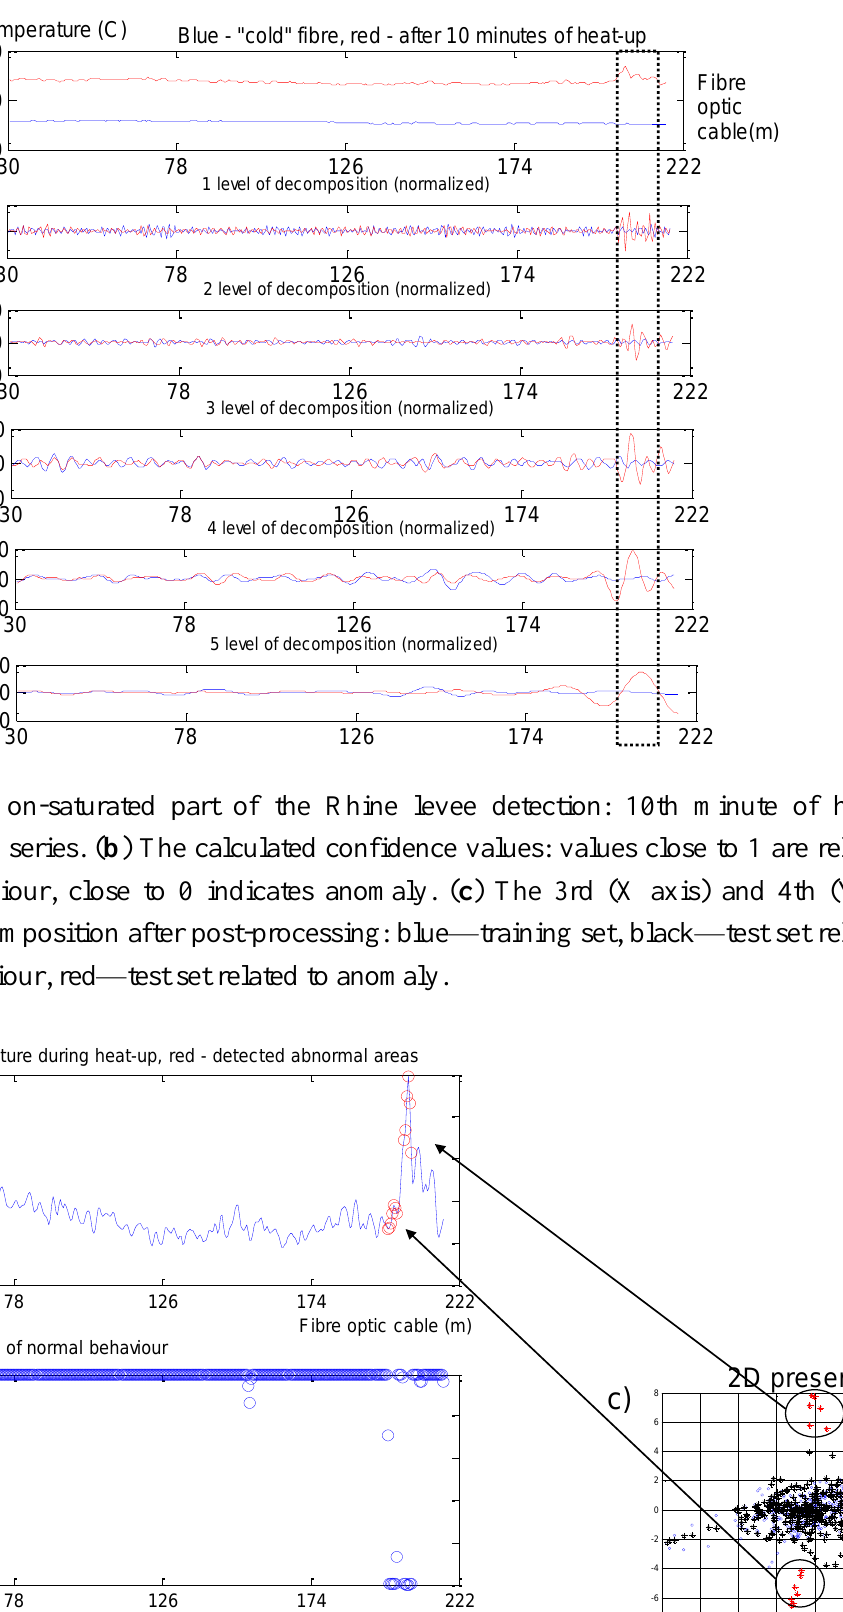
Figure 15. Results of MODWT application: X axis is the length of the cable (m), Y axis is temperature (Celsius). Dotted box shows position of the non-saturated part of the Rhine levee.